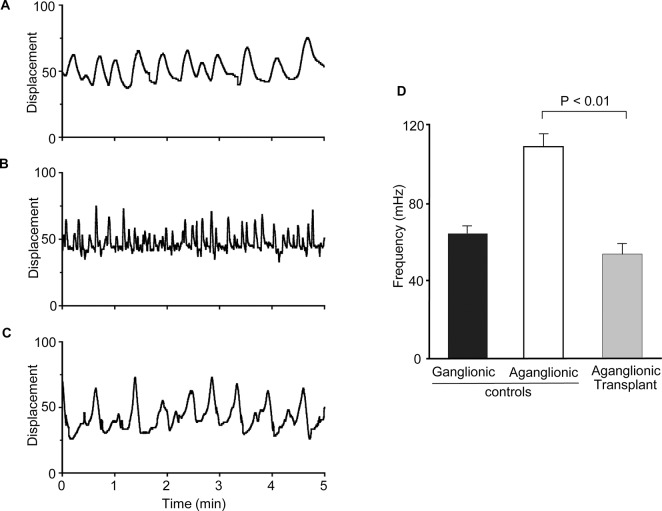
Effect of transplanted neurospheres derived from aganglionic human Hirschsprung bowel on the contractility of cultured embryonic mouse gut explants.Contractility was analysed after 8 days culture with/without neurosphere transplants using Diamtrak image analysis software. Ganglionic control explants displayed a slow, regular and uniform pattern of contraction (A). Aganglionic control explants displayed faster, and irregular contractility in comparison to the ganglionic pattern (B). Aganglionic explants after transplantation with a single neurosphere derived from human Hirschsprung aganglionic gut (C). Note that the pattern of contractility is now slower and more regular, similar to that of the ganglionic mouse explant (A). Single traces are shown which are representative of >5 separate experiments for each condition. Analysis of the frequency of contractions (D). Acquisition of data was gated to exclude small displacements less than 5% of the diameter of the gut wall. The contraction frequency of transplanted explants (C) was significantly lower (p<0.01) than that of untransplanted controls (B), but there was no significant difference between the slower contractions of ganglionic controls (A) and those of aganglionic gut explants after transplantation (ANOVA). Means ± SD are shown (n = 5).